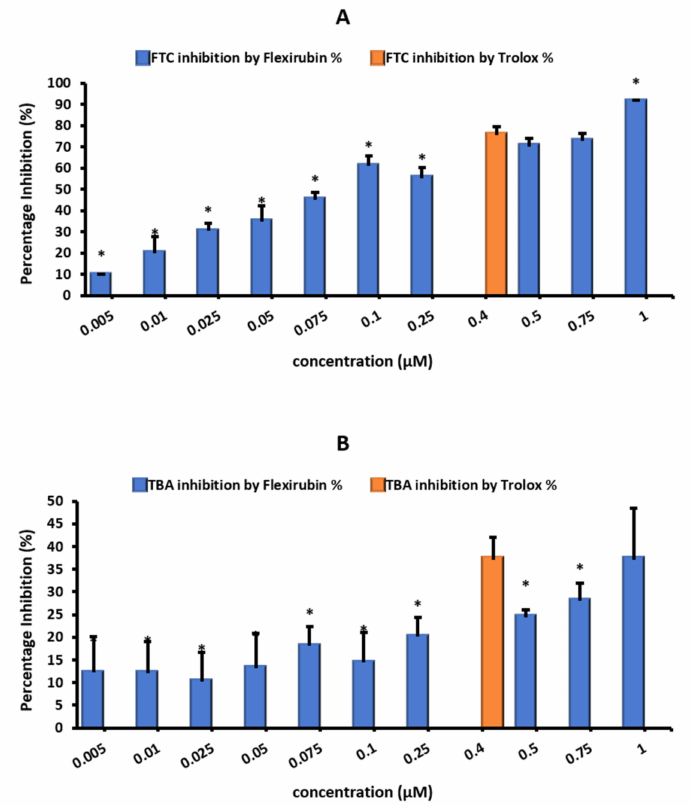
Figure 6. Antioxidant activity of flexirubin extracts at different concentrations (0.005–1 µ M) using a metal complexation and reducing abilities. ( A ) Ferric reducing antioxidant power (FRAP). ( B ) Ferrous complexation ability. Each point represents the mean ± SD ( n = 3); * shows statistically significant differences at p ≤ 0.05 in the observed activities when compared with that of Trolox or Ascorbic acid